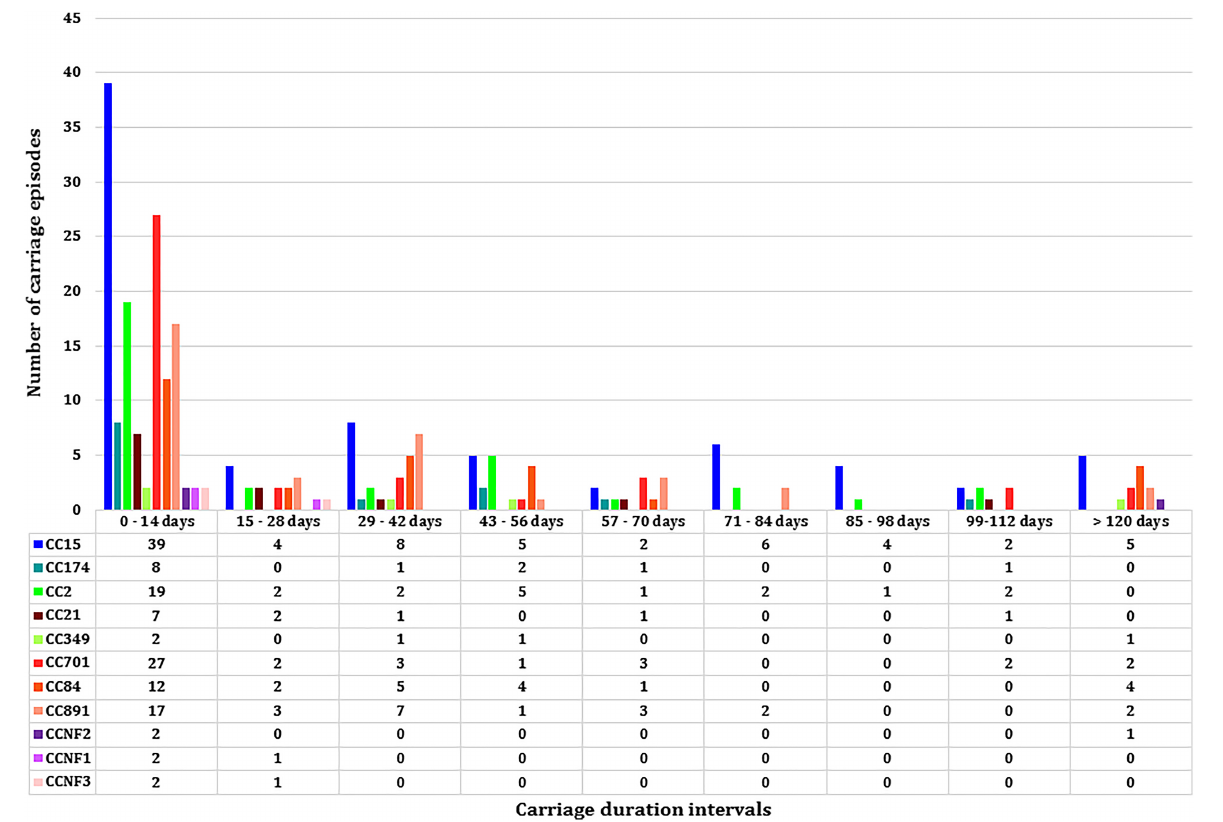
Frontiers in Genetics |